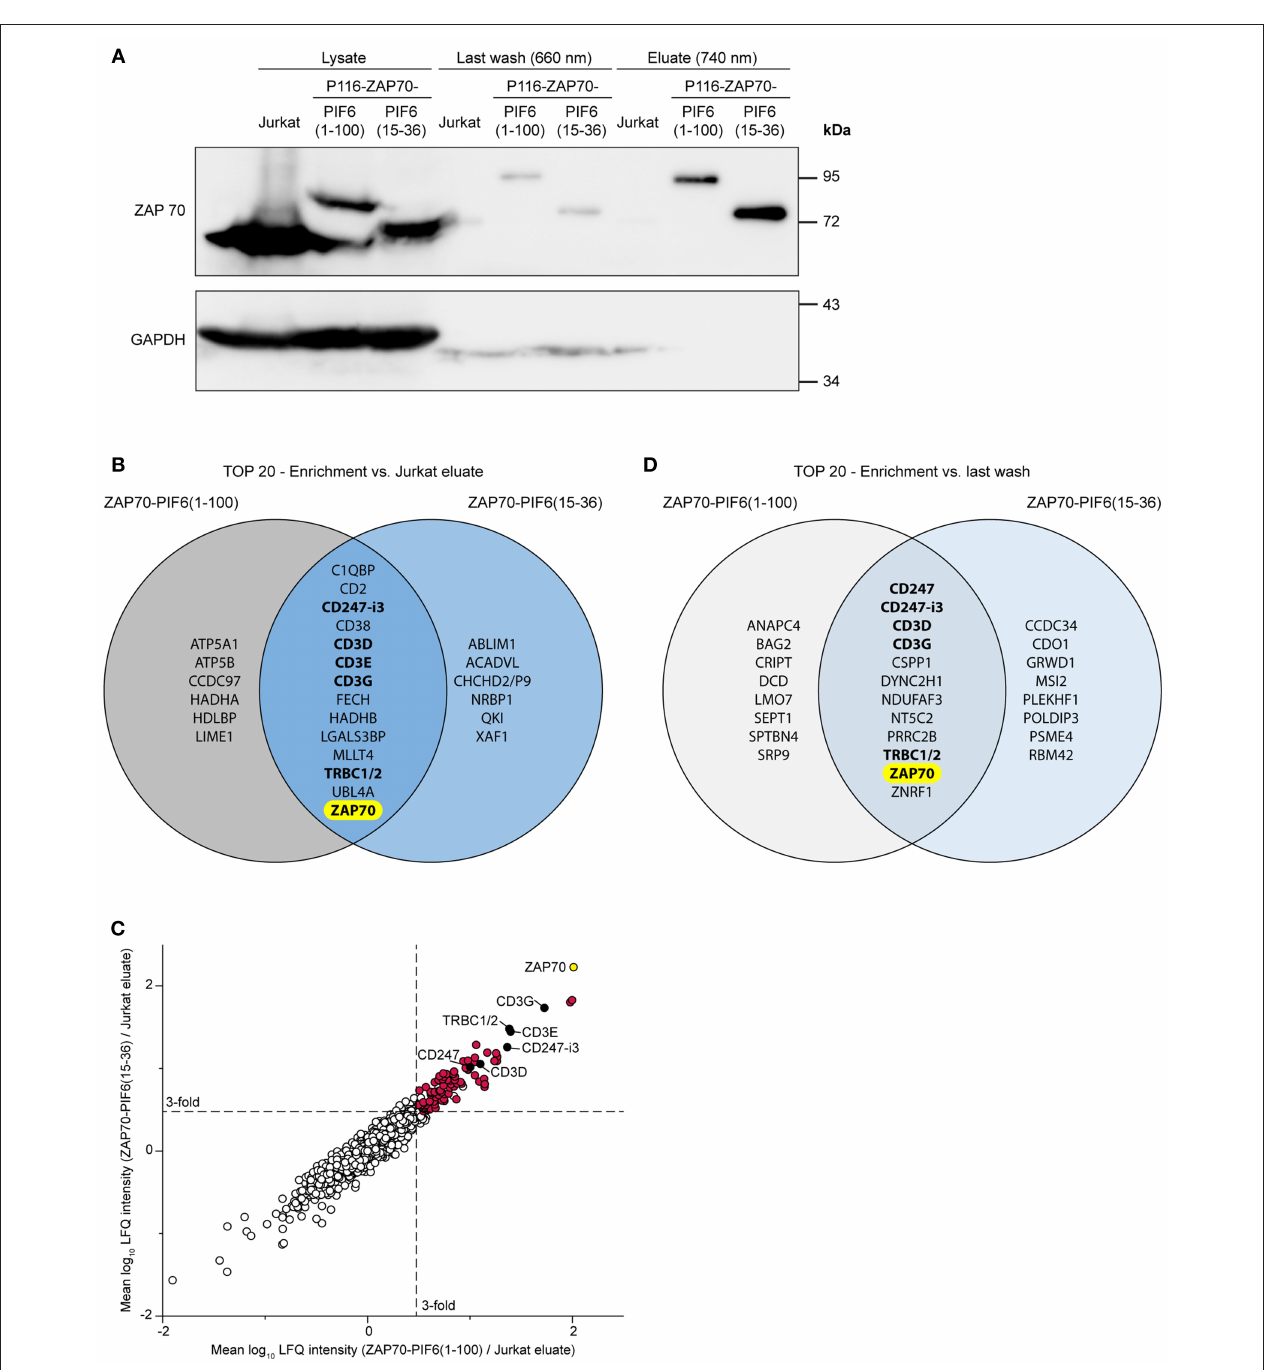
FIGURE 5 | Analysis of light-controlled ZAP70-PIF purification by mass spectrometry. Jurkat cells and P116-derived cell lines stably expressing ZAP70-PIF6(1-100) or ZAP70-PIF6(15-36) were lysed and PIF-tagged proteins were light-controlled purified using PhyB* beads ( n = 3 biological replicates). All eluates and the flow-throughs of the last washing were analyzed by mass spectrometry. (A) Analysis of the cell lysates, the flow-throughs of the last washing step and the eluates by SDS-PAGE and Western blot against ZAP70 and GAPDH. (B) Comparison of the 20 best hits ( p < 0.05, sorted on protein enrichment) enriched in the eluates of each ZAP70-PIF6 cell line vs. the eluates from the Jurkat cell line. Known interaction partners of ZAP70 are written in bold. (C) Enrichment of proteins identified in the ZAP70-PIF6(1-100) eluate vs. the Jurkat eluate (x-axis) plotted against the enrichment of proteins in the ZAP70-PIF6(15-36) eluate vs. the Jurkat eluate (y-axis). The enrichment for each protein is shown as the mean log 10 ratio of the label-free quantification (LFQ) intensities (3 biological replicates) of the compared samples. Known interaction partners of ZAP70 identified in (B) are highlighted in black and are labeled. All significant hits ( p < 0.05) in the upper right quadrant are highlighted in red. The POI ZAP70 is highlighted in yellow. Dashed lines represent a ratio cut-off corresponding to a 3-fold enrichment compared to the Jurkat eluate. (D) Comparison of the 20 best hits ( p < 0.05, sorted on protein enrichment) enriched in the eluates of each ZAP70-PIF6 cell line vs. the flow-throughs of the last washing step. Known interaction partners of ZAP70 are written in bold. CHCHD2/P9, CHCHD2, CHCHD2P9; CD247-i3, CD247 isoform 3; TRBC1/2, TRBC1, TRBC2.